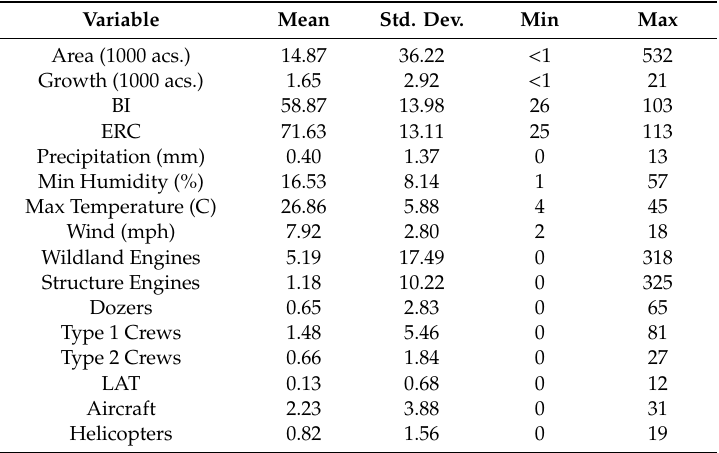
Table 3. Summary Statistics of data used in all regressions.